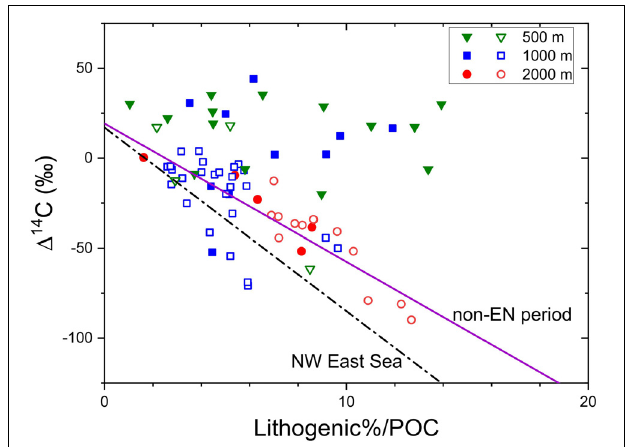
) against the ratio of the content of lithogenic FIGURE 6 | (cid:49) 14 C values ( material to the POC of sinking particles. Open and closed symbols denote the (cid:104) non-EN and EN periods, respectively. Data from Station EC1 are included as non-EN period samples (Kim et al., 2017). The solid line denotes the linear fit of the non-EN period data and the dashed line denotes the linear fit of Japan Basin (Northwest East Sea; Otosaka et al., 2008; Kim et al.,